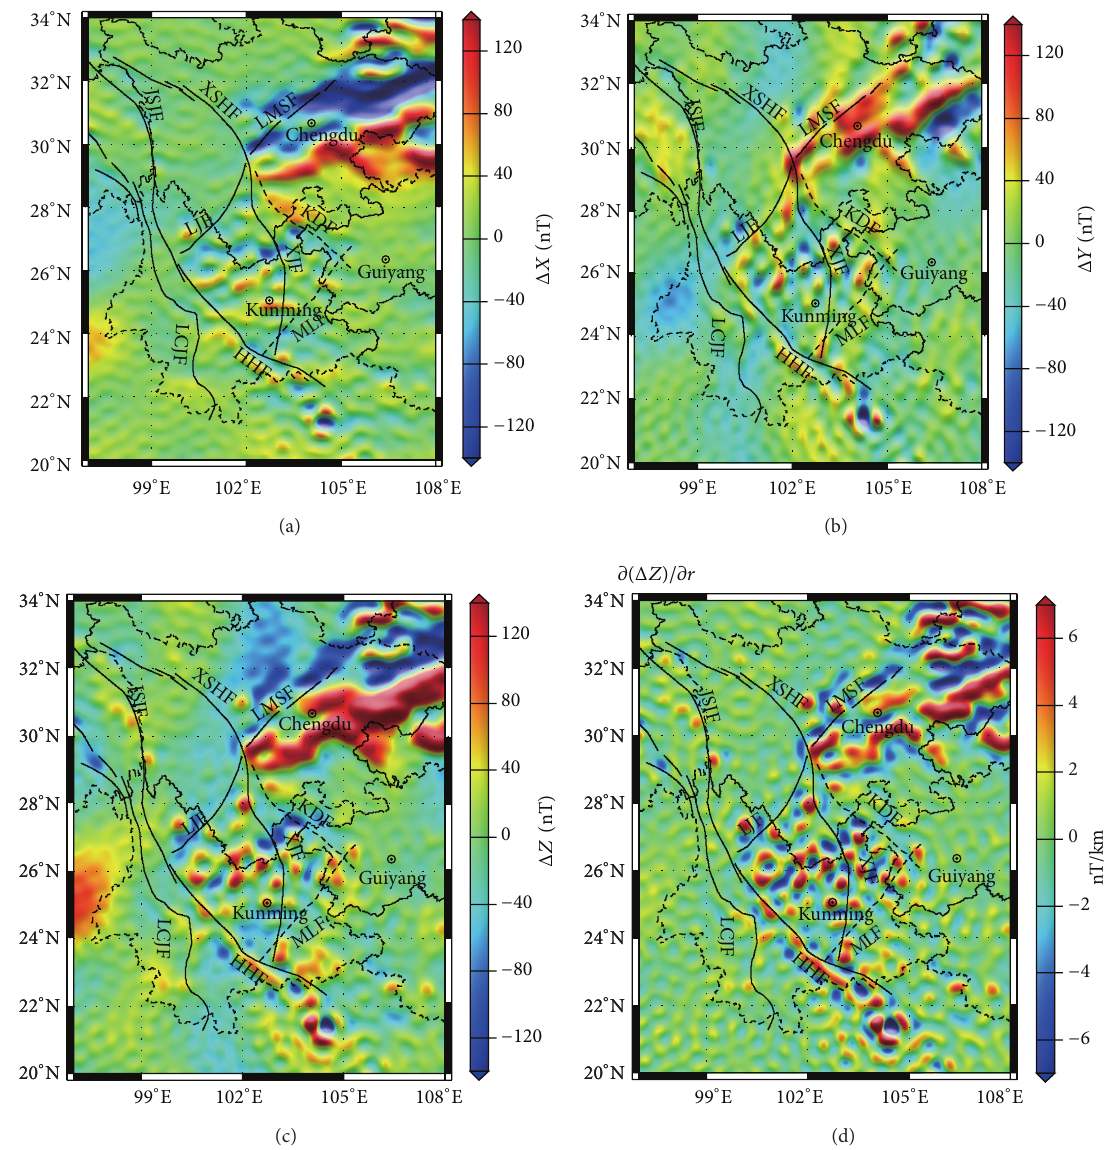
Figure 2: Distribution of the crustal magnetic anomaly of (a) Δ𝑋 , (b) Δ𝑌 , (c) Δ𝑍 , and (d) 𝜕(Δ𝑍)/𝜕𝑟 at the Earth’s surface.